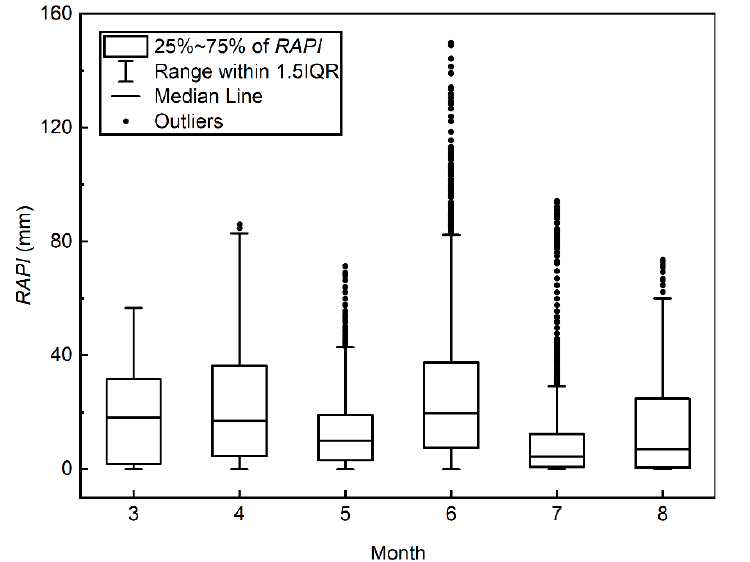
Figure 4. Statistical characteristics of the optimal RAPI .